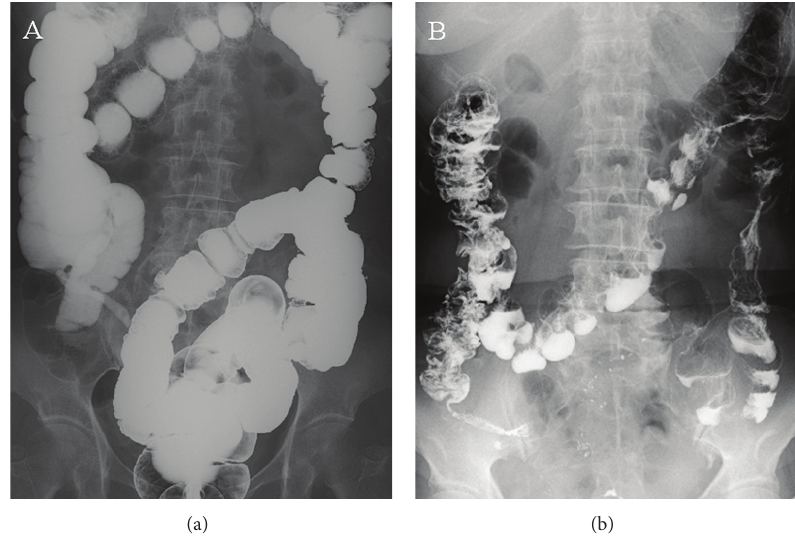
Figure 2: Barium radiography for colonic diverticular bleeding. (a) High-dose barium filling the entire colon by barium impaction therapy. (b) Abdominal radiograph showing barium retention in colonic diverticula taken the next day after barium impaction